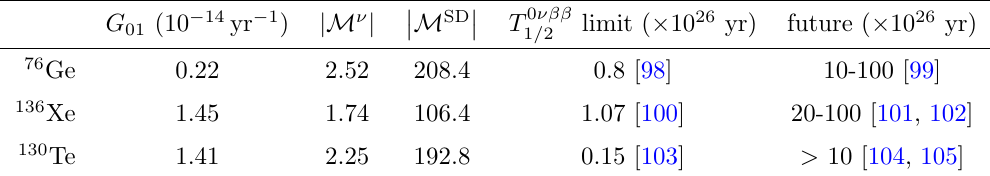
(cid:12) (cid:23) SD (cid:12) (cid:12) and (cid:12) jM j M